Question: What does this figure show? Answer in one sentence.
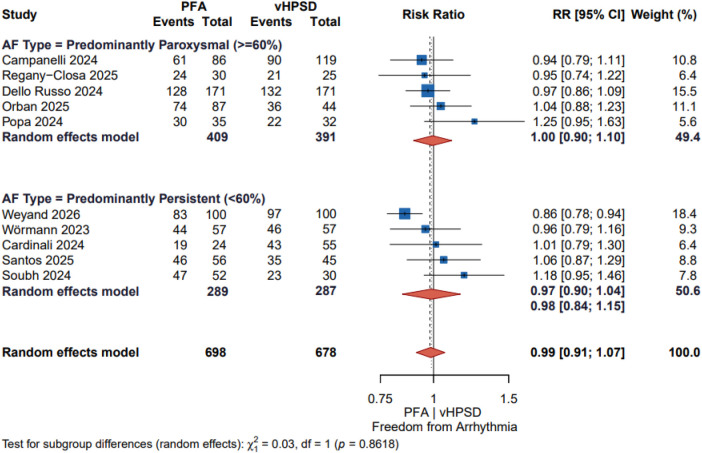
Answer: Forest plot of the subgroup analysis.